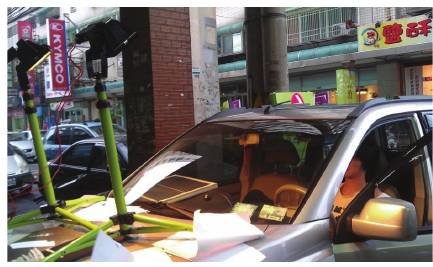
Figure 13: Overview of the experimental